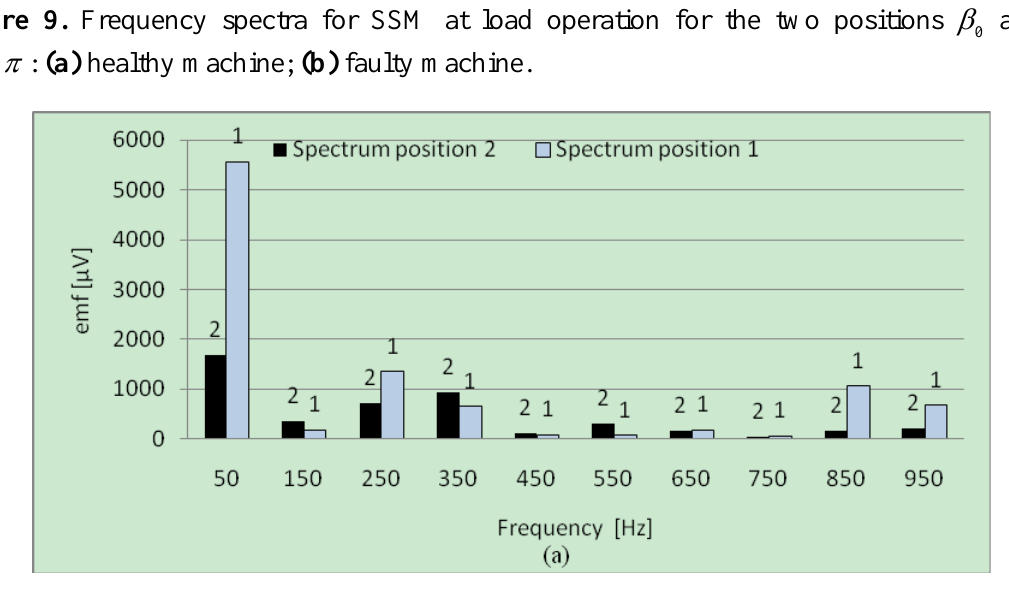
Figure 9. Frequency spectra for SSM at load operation for the two